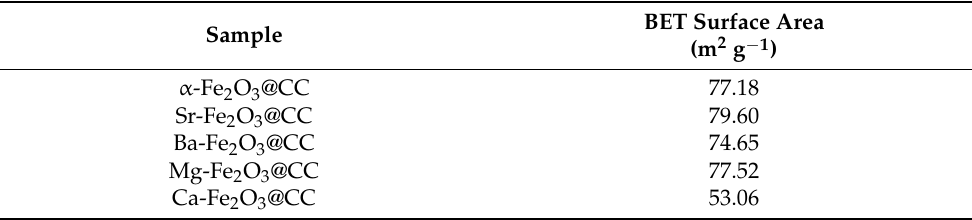
Table 2. BET surface area for α -Fe 2 O 3 @CC, Sr-Fe 2 O 3 @CC, Ba-Fe 2 O 3 @CC, Mg-Fe 2 O 3 @CC,